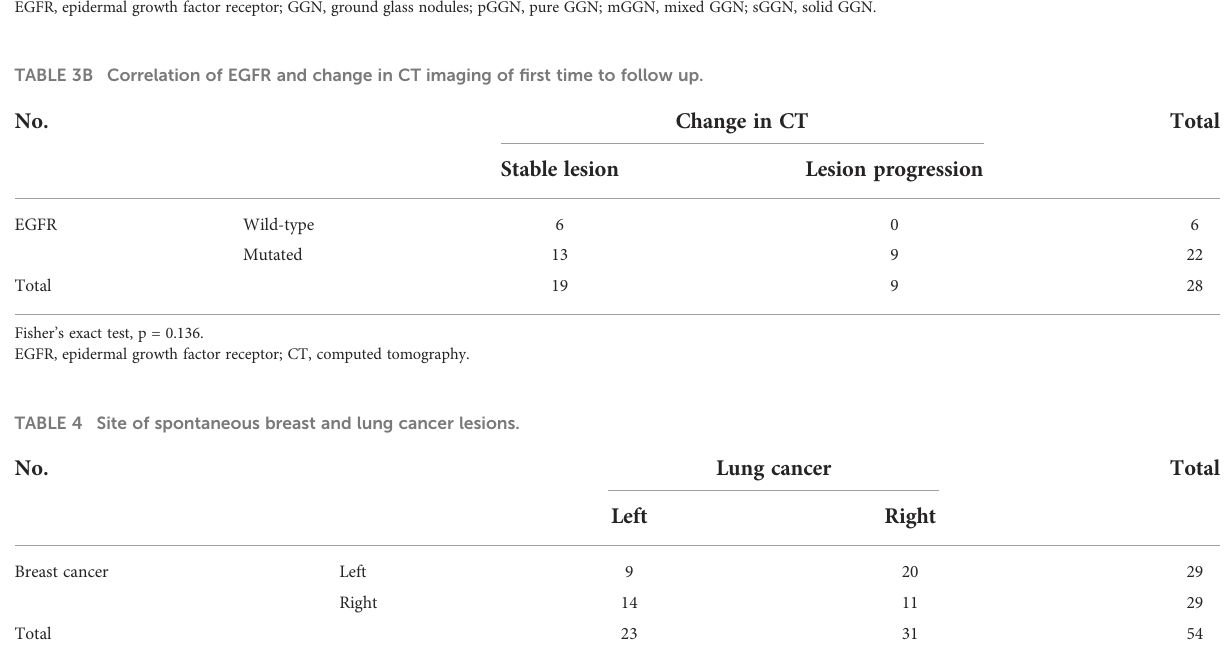
Total Chi-square 3.42 p =